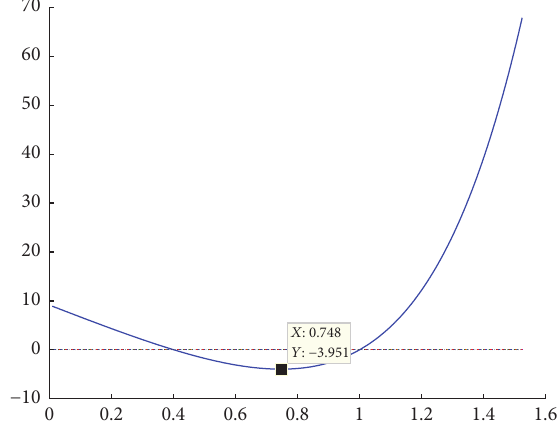
Figure5:Hereweseeaplotof Φ(𝑠) versus 𝑠 fortheotherparameters as mentioned earlier from [26], 𝑟 = 0.5 , 𝑚 = 1 , 𝑢 = 0.1 , 𝛾 = 1.5 , 𝑡 1 = 1.3 .Weclearlyseethat (𝑑Φ(𝑠)/𝑑𝑠)| 0 . The root occurs at approximately 𝑠 = 1.001